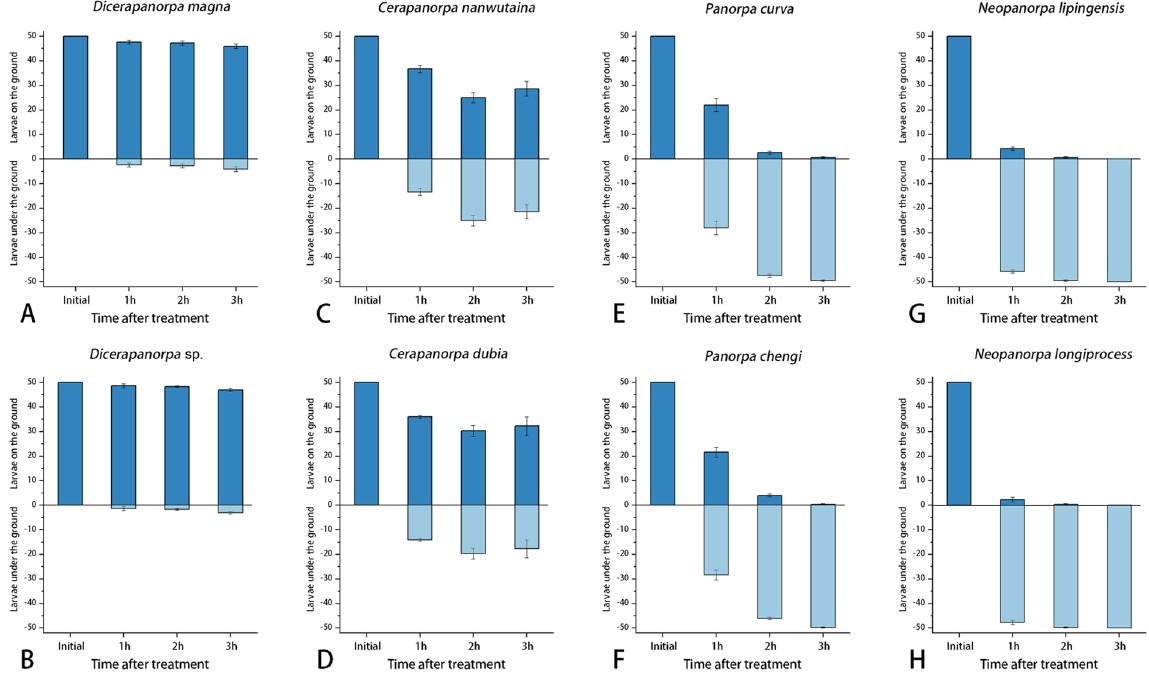
Figure 4. The number of larvae on/under the ground in three successive hours (Mean ± SEM, n = 3), showing the habitat preference of larvae. ( A ) Dicerapanorpa magna ; ( B ) Dicerapanorpa sp.; ( C ) Cerapanorpa nanwutaina ; ( D ) Cerapanorpa dubia ; ( E ) Panorpa curva ; ( F ) Panorpa chengi ; ( G ) Neopanorpa lipingensis ; ( H ) Neopanorpa longiprocessa